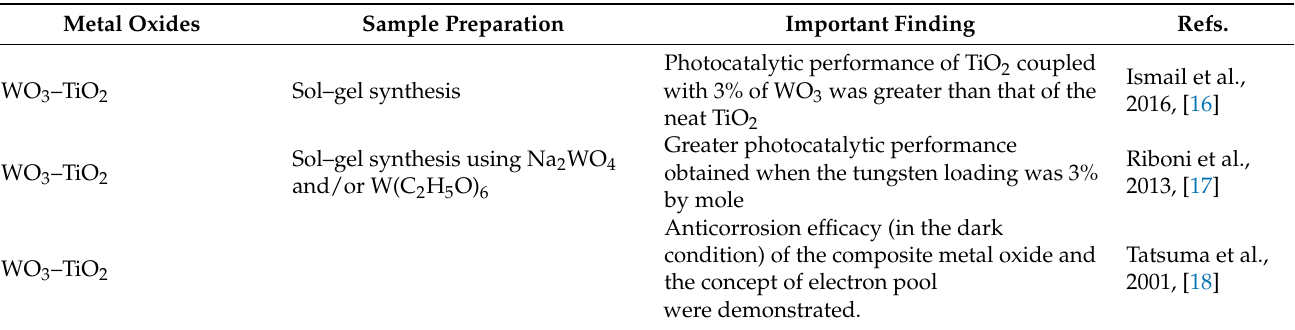
Table 2. Summarized photocatalytic performance and antifouling efficacy of various metal oxides from the